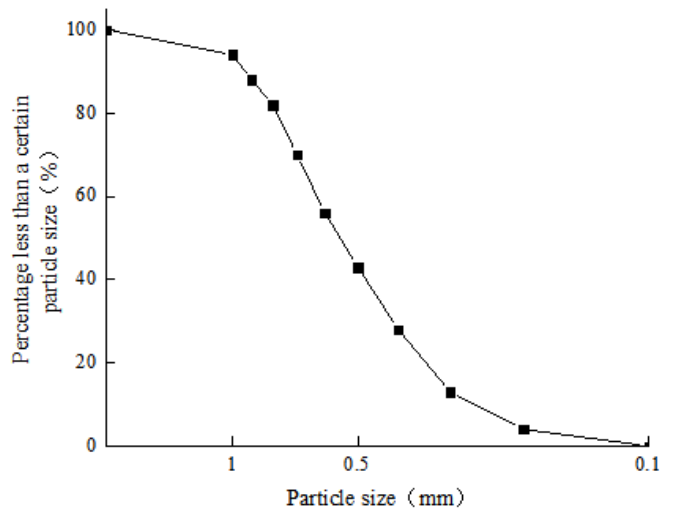
Figure 2. X-ray diffraction pattern of clay.